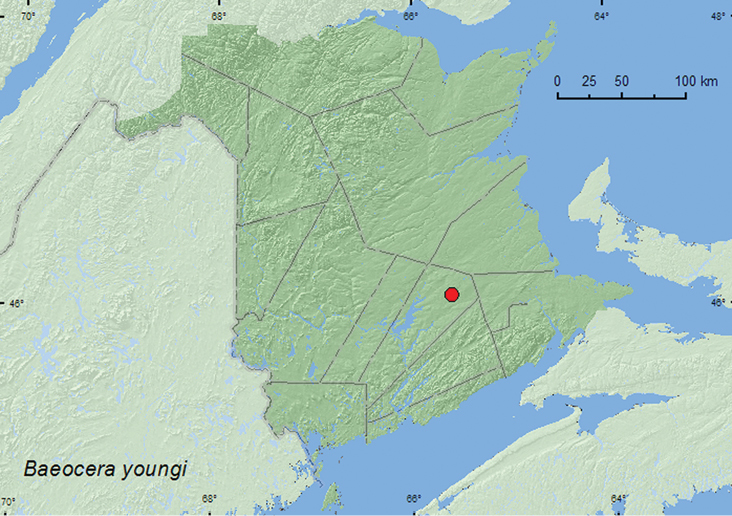
Collection localities in New Brunswick, Canada of Baeocera youngi.